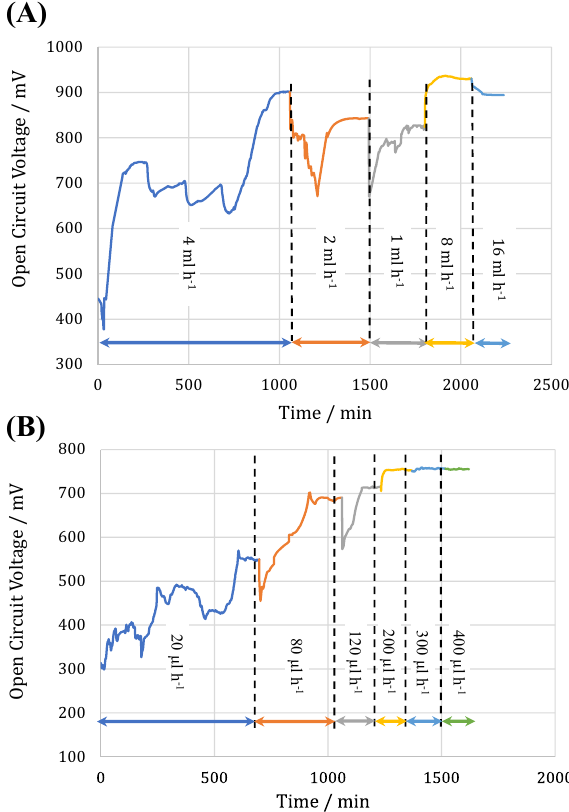
Figure 3. The open circuit voltage (OCV) evolution of ( A ) macro-scale and ( B ) micro-scale